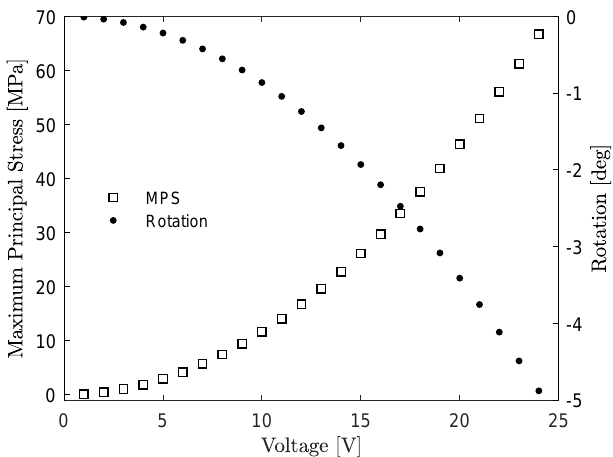
Figure 7. Second layout: maximum values of the MPS and rotation angle of the movable fingers for increasing values of the applied voltage.